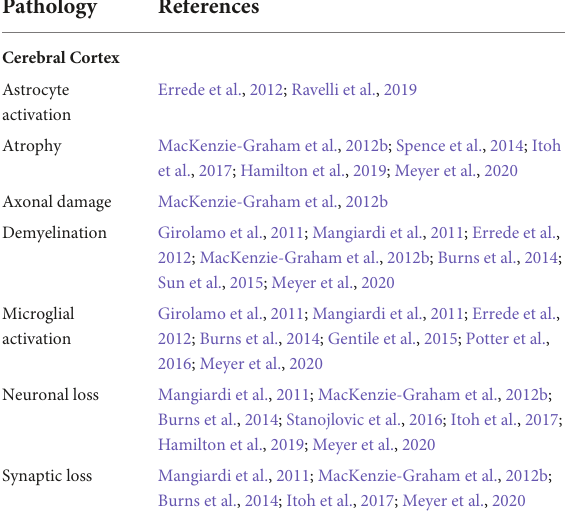
TABLE 1 Pathologies in the cerebral cortex in